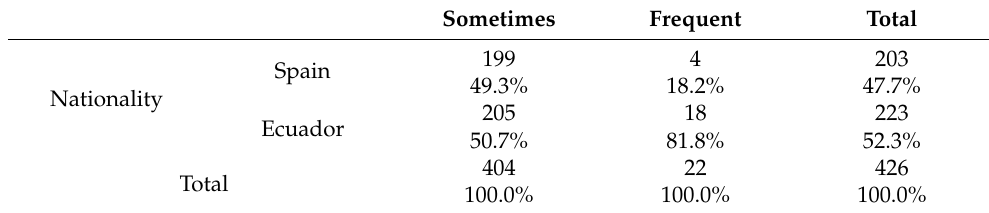
Table 2. Frequency of violence.